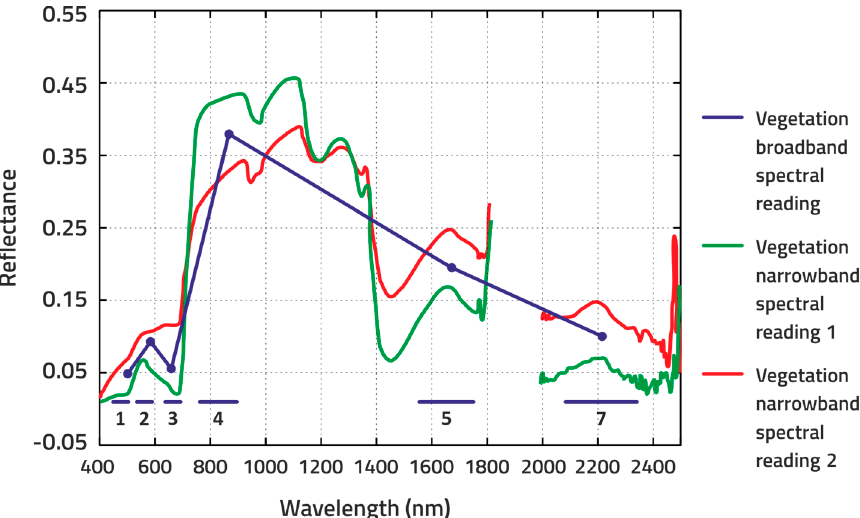
Figure 2. Broadband sensors’ inability for accessing the spectral shift of the RE (670–780 nm) slope associated with leaf chlorophyll content, phenological state and vegetation stress, comparatively to wide-range narrowband ones (re-edited from [18]).